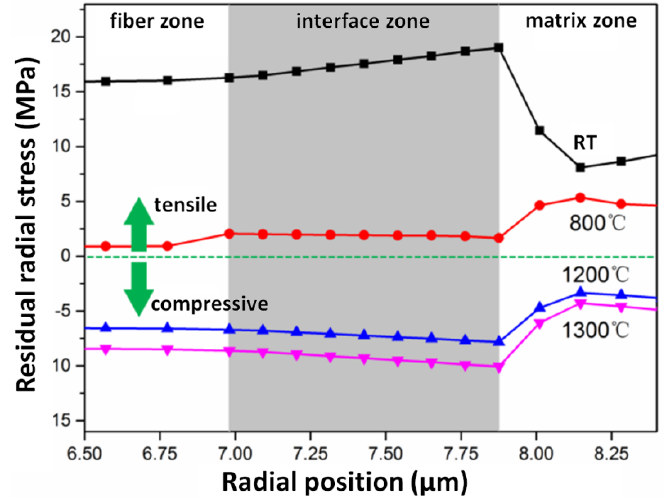
Figure 6. Distribution of residual radial stress, σ RR of SiC–SiC at di ff erent